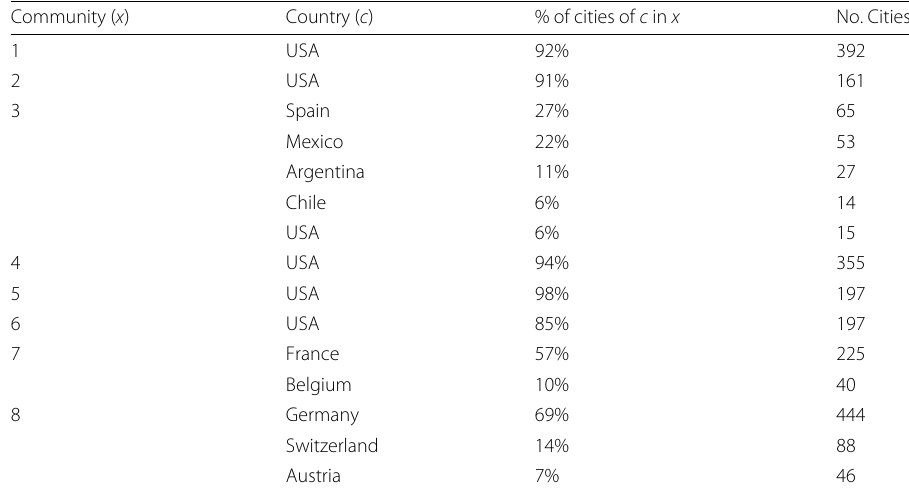
Table 4 Breakdown of communities by country. For each modularity class the number of cities belonging to a country are listed along with their proportion of cities in the class. For example community 16 is composed of 25% Swedish, 22% Finnish, 20% Norwegian and 16% Danish cities as well as 17% smaller cities. Note: only countries with at least 5% member cities are listed Community ( x ) Country ( c ) % of cities of c in x No. Cities